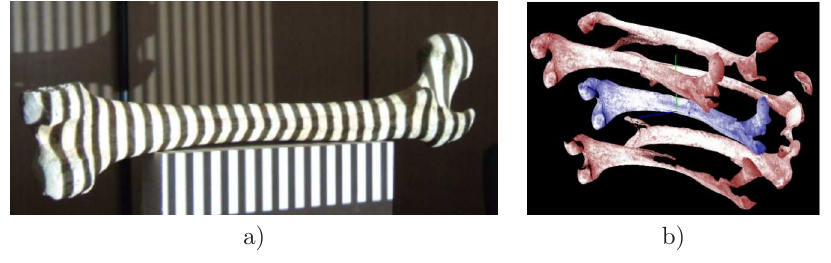
Figure 3. Data acquisition process on 3D structural light scanner and a set of point clouds.